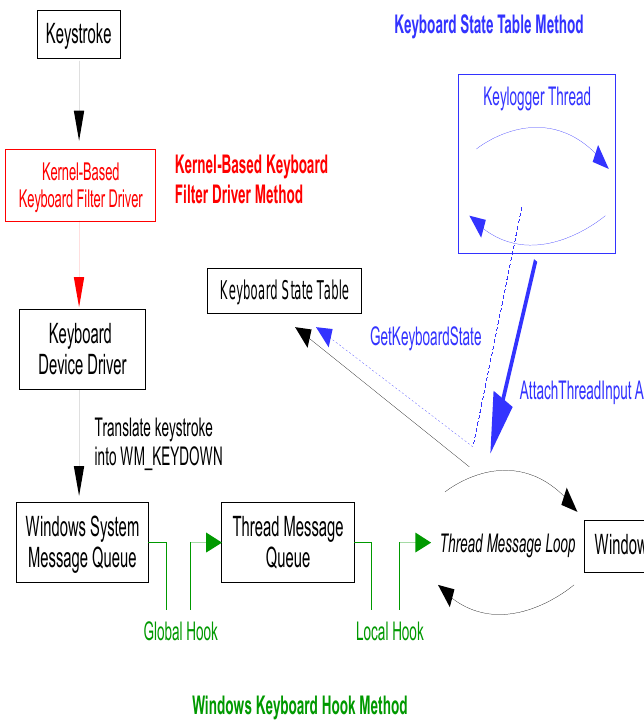
Figure 1. Processing keystrokes in Windows with keylogging